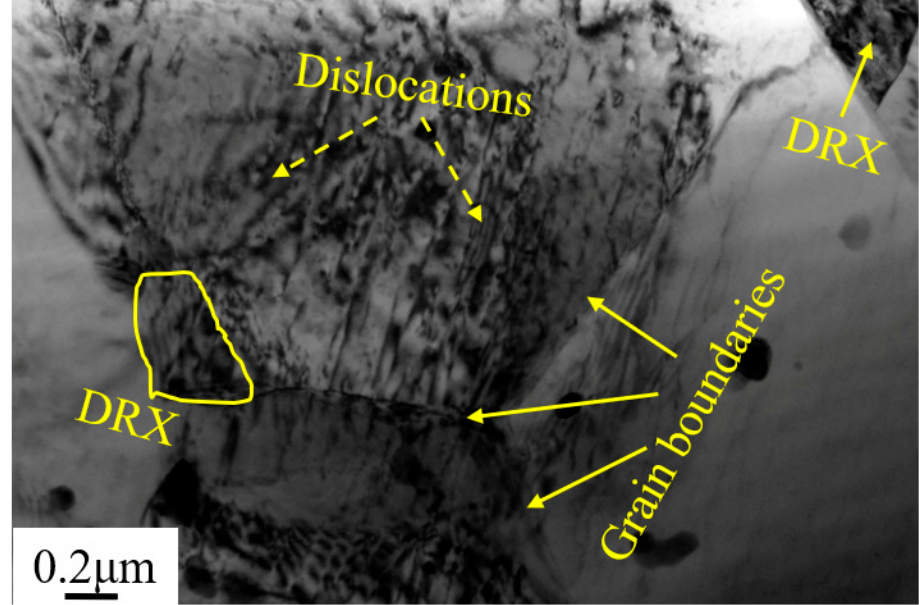
Figure 4. TEM microstructure of the Mg-5Zn alloy with a compression strain of 0.35. As the compression strain of the Mg-5Zn alloy increased to ~0.7, the large deformed grains obviously disappeared, while the amount of fine DRXed grains increased. The av- erage DRXed grain size and volume fraction were ~4.4 μ m and ~72%, respectively, as shown in Figure 2d1,d2.